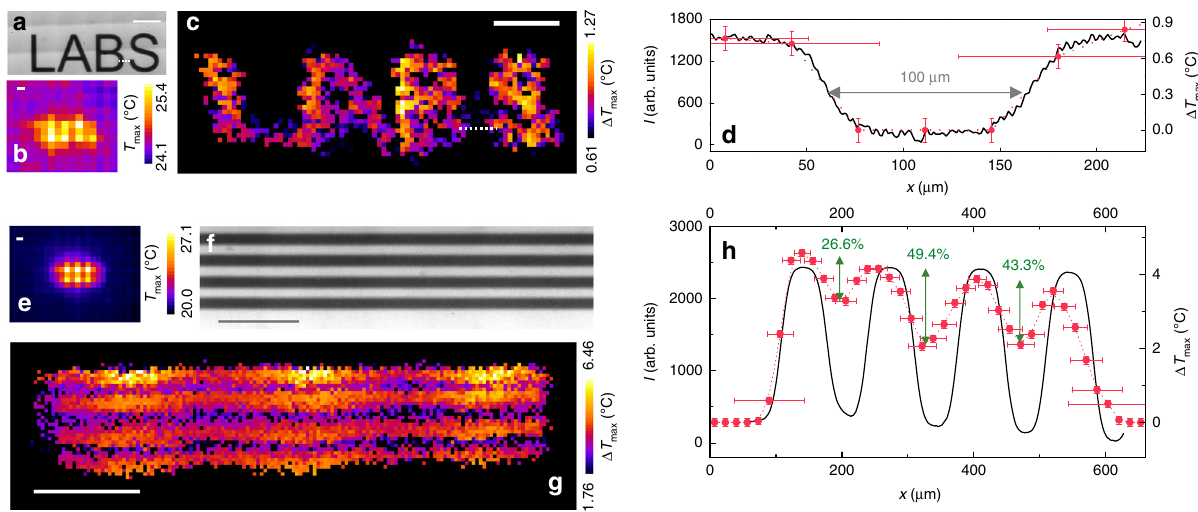
Fig. 2 Proof-of-principle experiments. a , f Transmitted-light images of micro fi che samples. b , e Temporal maximum projection of the raw thermo-camera image stacks acquired with modulated illumination on the samples in a and f , respectively; acquisition parameters: N x x N y = 120 × 36, δ x = 34.4 μ m, Δ x = 60, Δ y = 6, τ on = 300 ms, P = 4.6 mW, beam 1/e 2 diameter 56 ± 2 μ m in b , N x x N y = 160 × 42, δ x = 15.3 μ m, Δ x = 160, Δ y = 6, τ on = 300 ms, P = 15 mW, beam diameter 22 ± 1 μ m in e . c , g Super-resolution images of the samples in a and f , obtained from the image stacks employed for b and e , respectively; Δ T = 0.3 °C in c , 0.7 °C in g . d Black: intensity pro fi le along the dashed line in a upon a lookup-table inversion on the image; red: Δ T fi le along the min max pro dashed line in c . h Black: average intensity pro fi le along the vertical direction in f upon lookup-table inversion; red: average Δ T max pro fi le along the vertical direction in g with contrast percentages between adjacent peaks. In d , h , uncertainties on Δ T max values equal the thermo-camera sensitivity 0.1 °C and x -axis error bars for non-zero Δ T σ x Δ T = 500 μ max values are extrapolated from the , y -versus- max plot. Scale bars